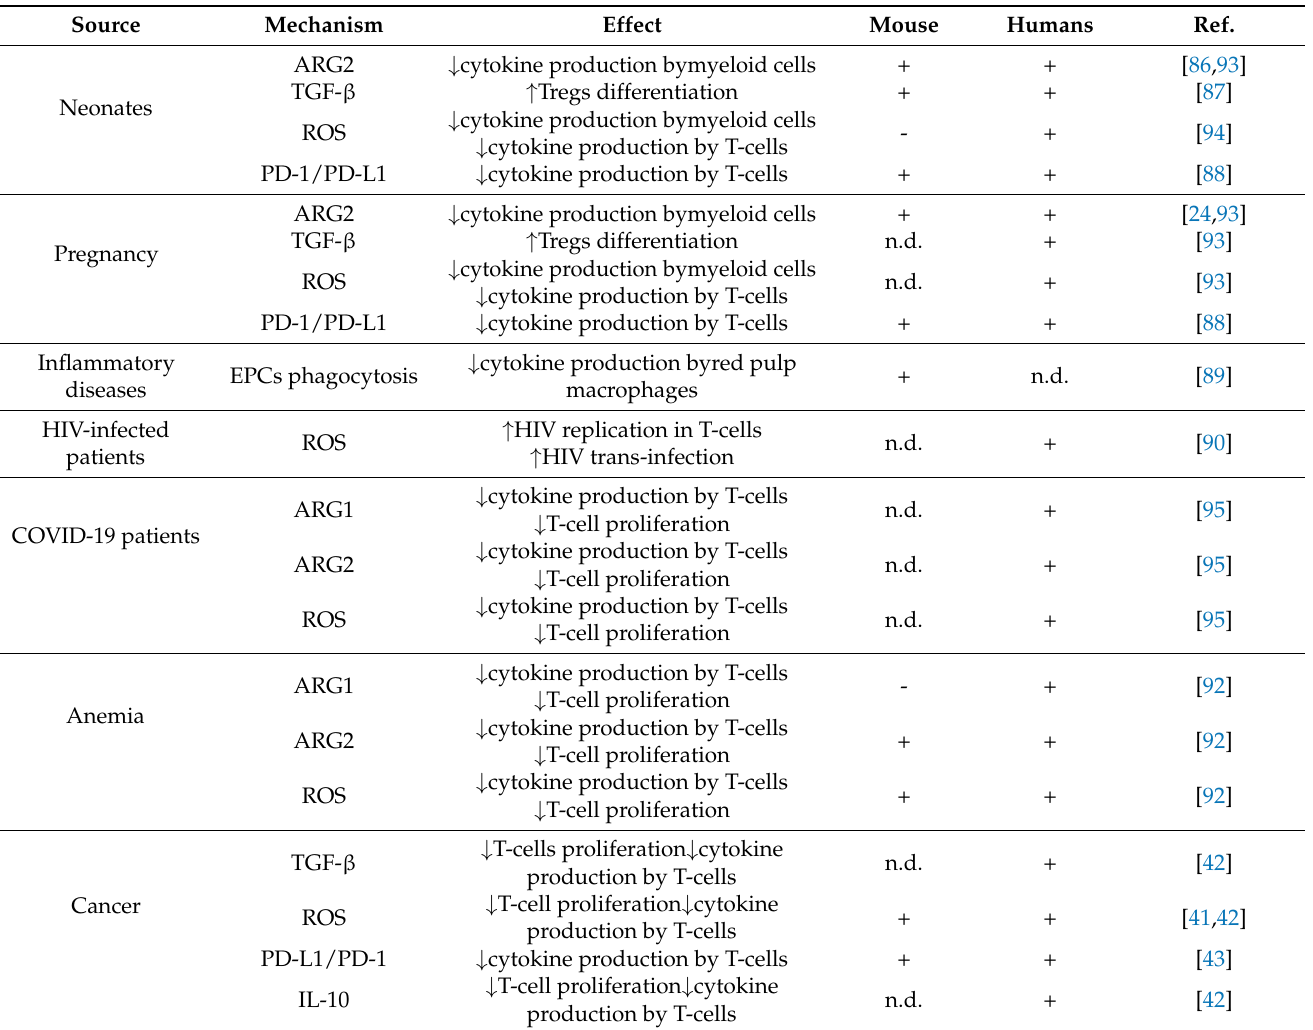
Table 3. Mechanisms of immunomodulatory functions of